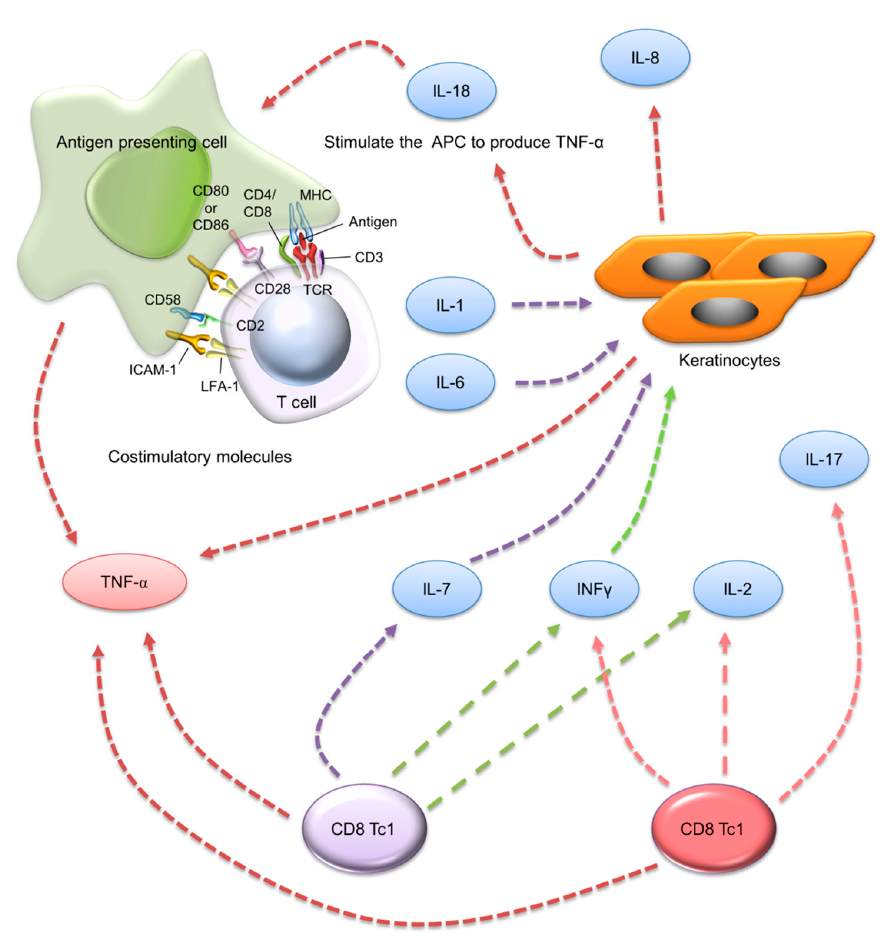
Figure 3. The apoptotic mechanisms of keratinocytes in psoriatic lesion.